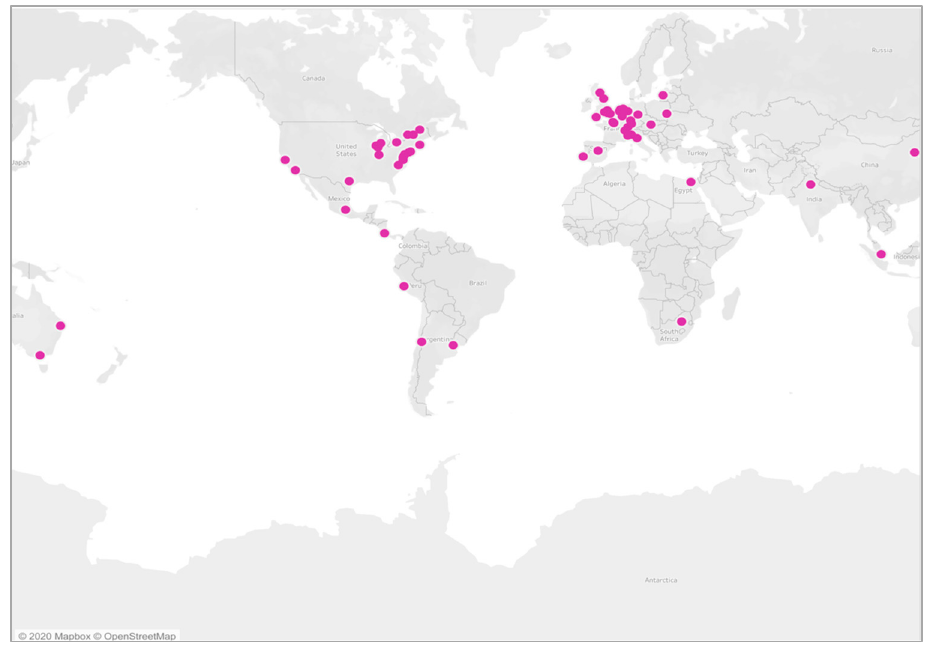
Figure 2. Universities with philanthropy centres across the world. Source: Langdon (2017).